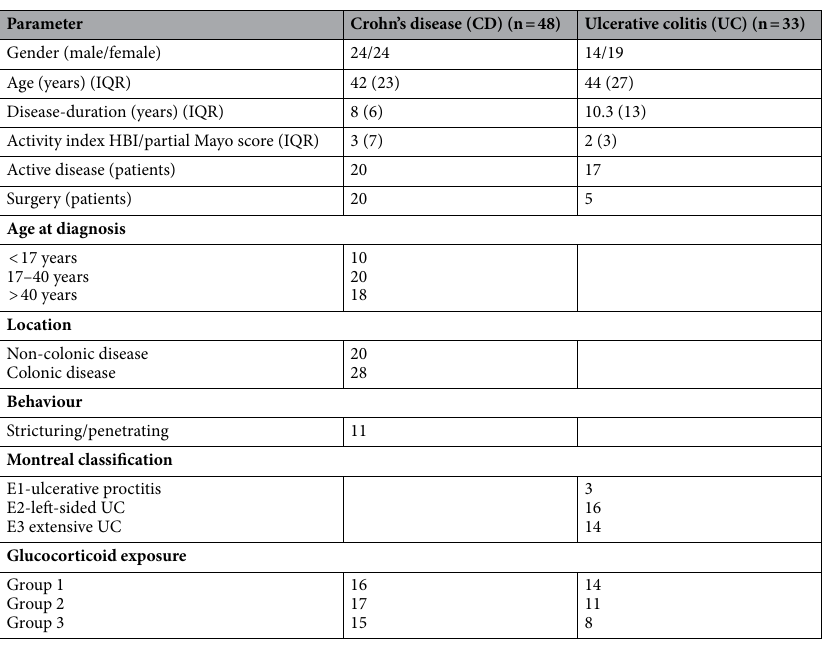
Table 1. Characteristics of IBD patients. Values are presented as median (IQR), number, according to the type of variable and the normality of distribution. BMI body mass index.